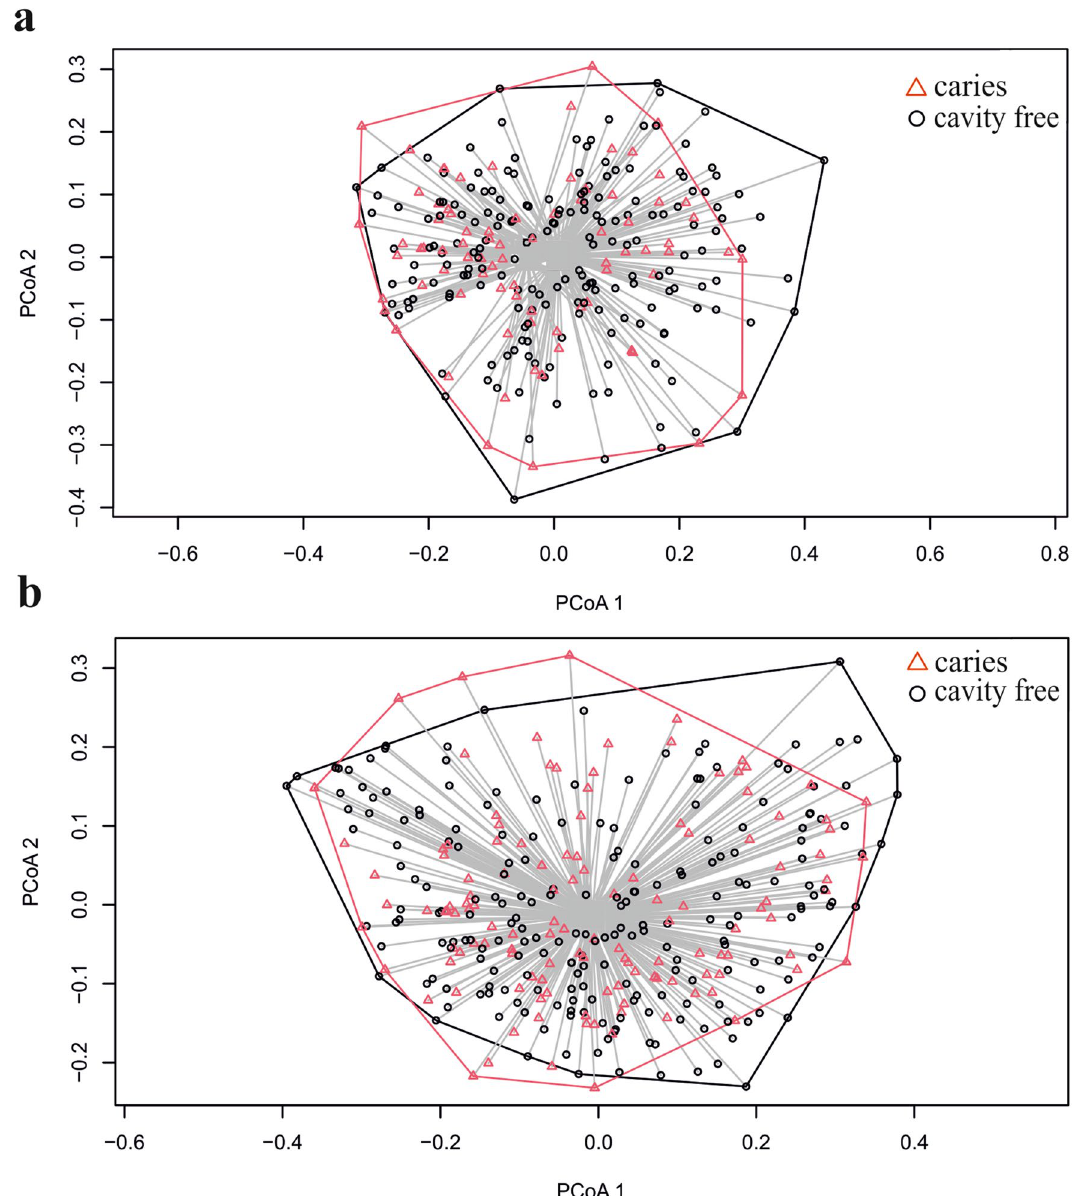
Figure 1. Principal coordinates analysis (PCoA) plot of abundance based on Bray–Curtis dissimilarity (beta diversity) of the saliva microbiota composition in caries and cavity free groups in boys ( a ) and girls ( b